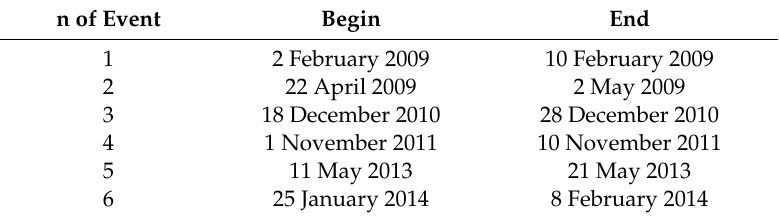
Table 1. List of flood events in the period of 2008–2017 selected for studying the e ff ectiveness of the waterway as a flood canal for the Brenta–Bacchiglione river network. n of Event Begin